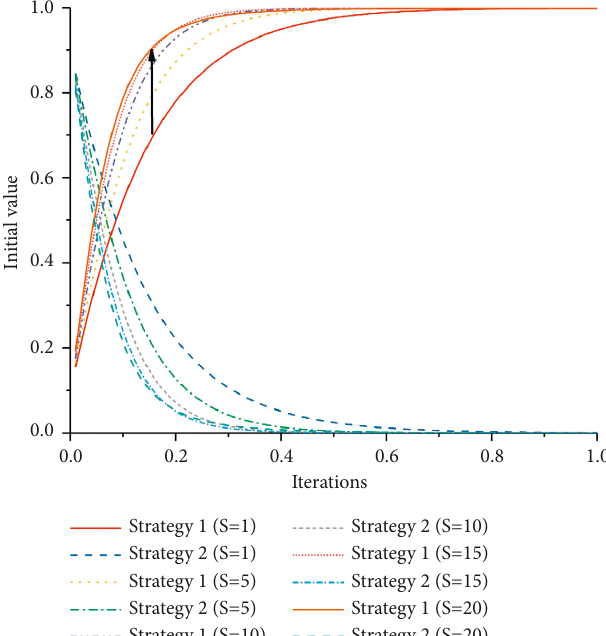
Figure 8: dx / dt − t in sensitivity analysis of S .